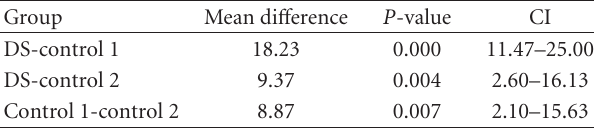
Table 2: PAR one-way ANOVA with pairwise Sche ff ´e comparisons between groups.